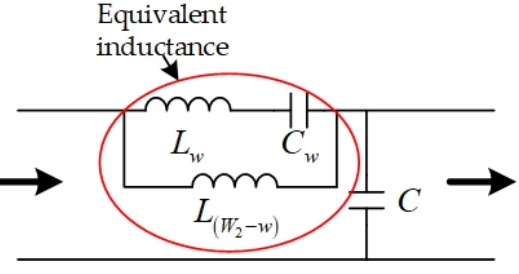
Figure 9. Transmission line model of the lead wire interconnection with the defect.